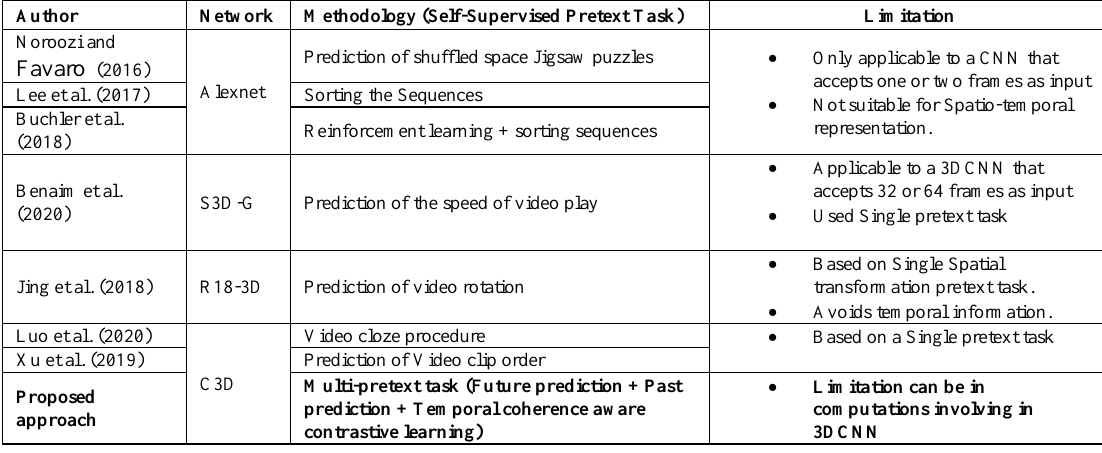
Table 1. Key related papers and their